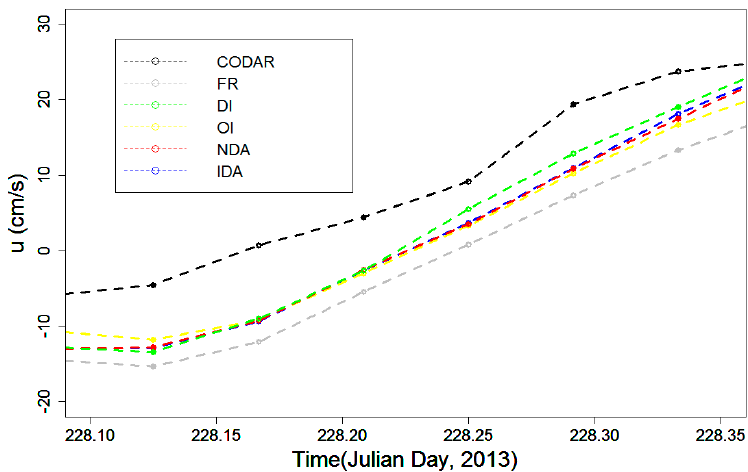
Figure 7. Time series of surface east–west velocity component (u) during forecasting period.